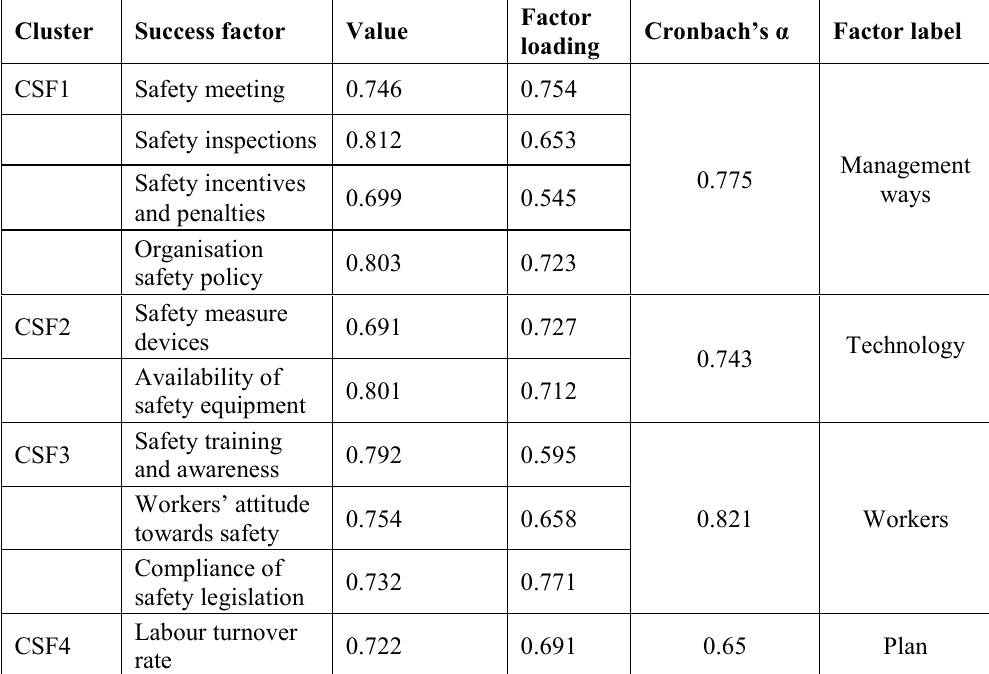
Table 2. CSFs Points of Construction